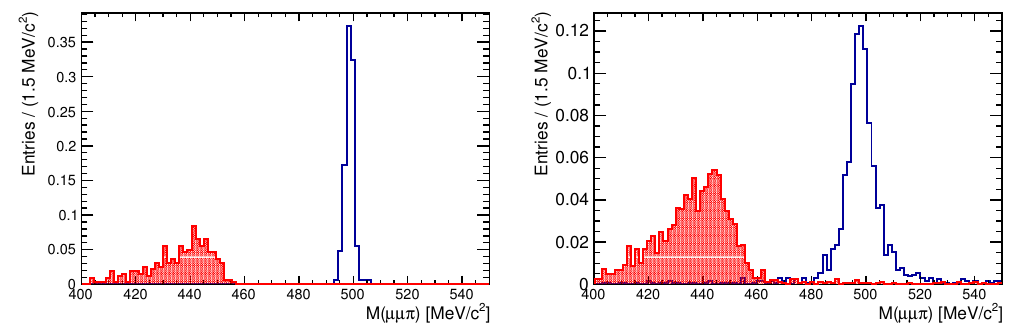
Figure 7 . Reconstructed invariant mass for K + (cid:25) + (cid:22) + (cid:22) (cid:0) , where signal events are shown with ! a solid blue line and K + (cid:25) + (cid:25) + (cid:25) (cid:0) background illustrated by red (cid:12)lled histograms. The left ! side gives events reconstructed with long tracks, while reconstruction with downstream tracks are pictured on the